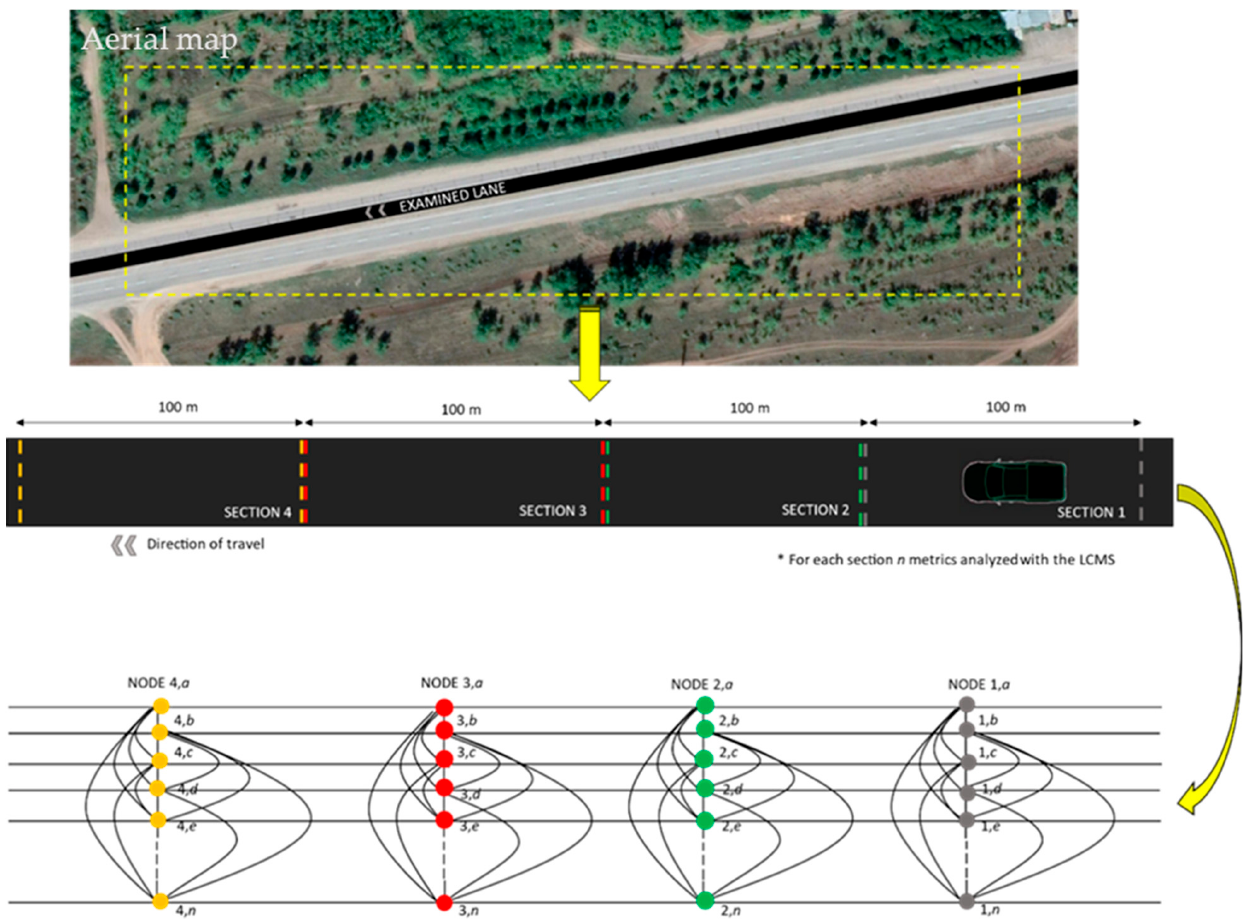
Figure 6. Distress road model as a signal on graph.